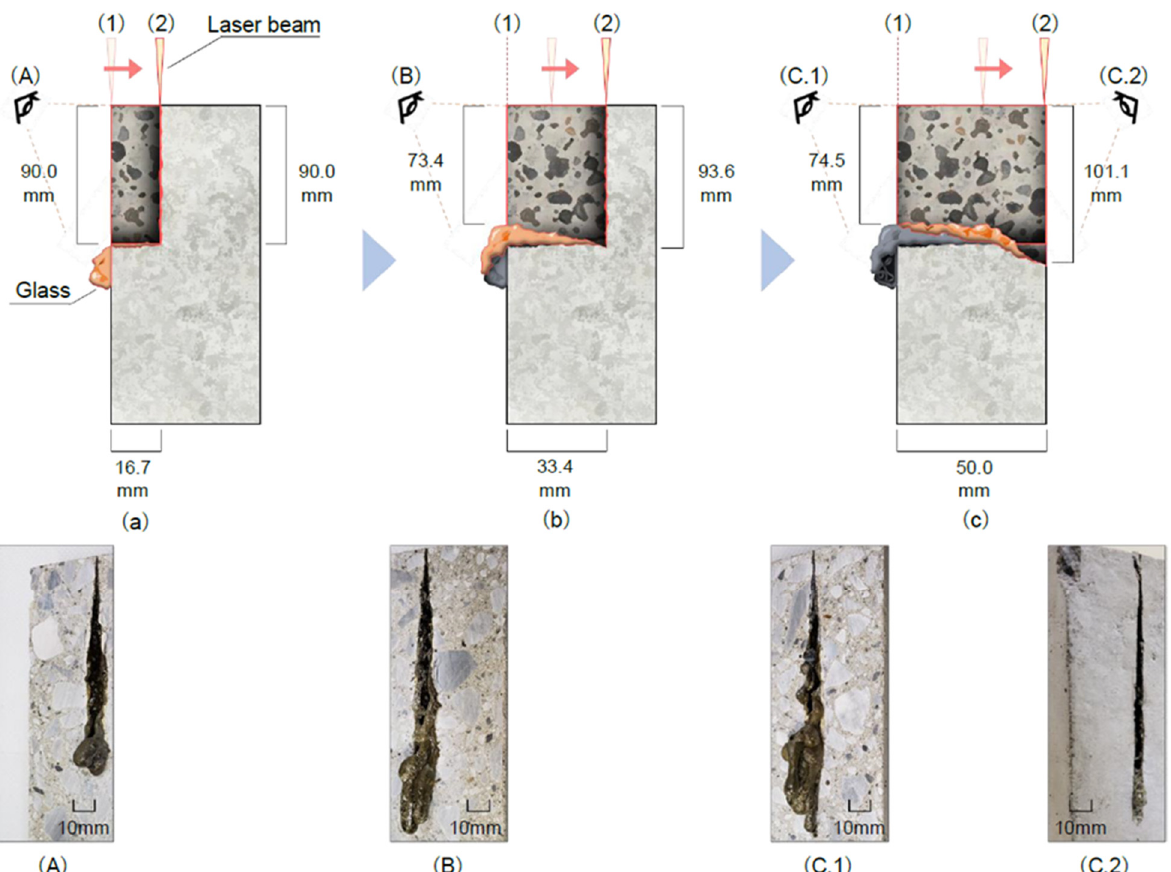
Figure 9. Schematic of the cutting difference owing to heat influence (laser: 9 kW; speed: 60 mm/min; strength: 20 N/mm 2 ).